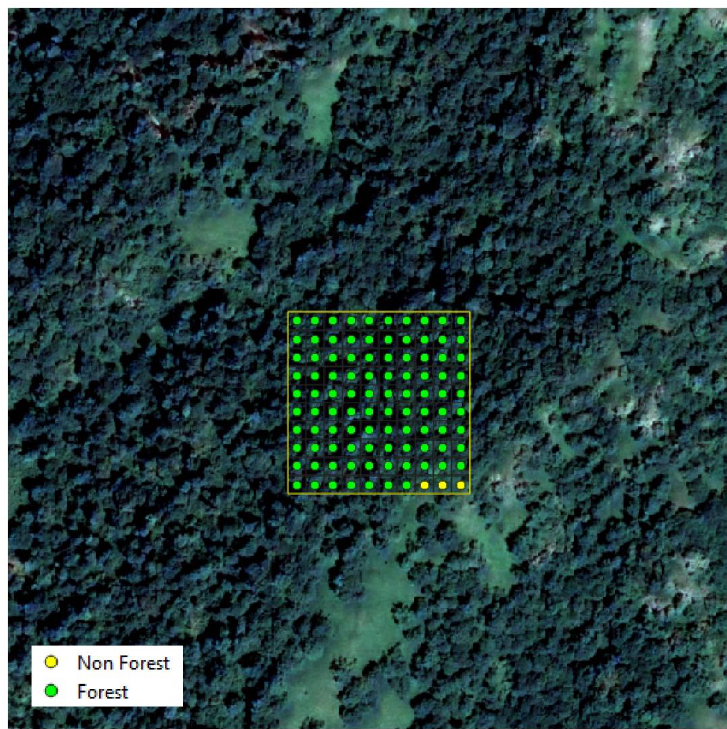
Figure 5. Visual interpretation of SSU points inside a PSU for computing the percentage of Forest Density reference value.